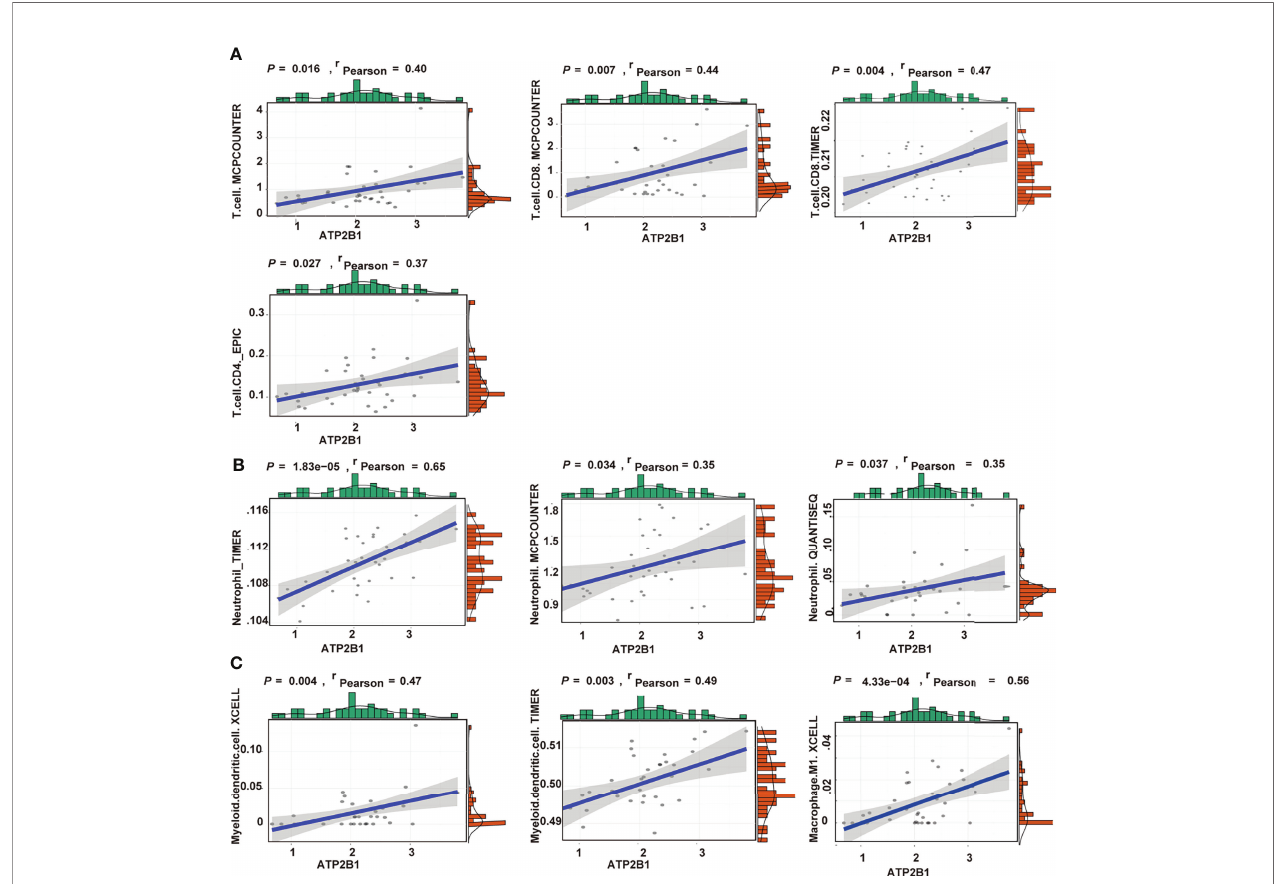
FIGURE 5 | Association of CD8+T cells, CD4+T cells (A) , neutrophil (B) , macrophage and myeloid dendritic cells (C) with ATP2B1